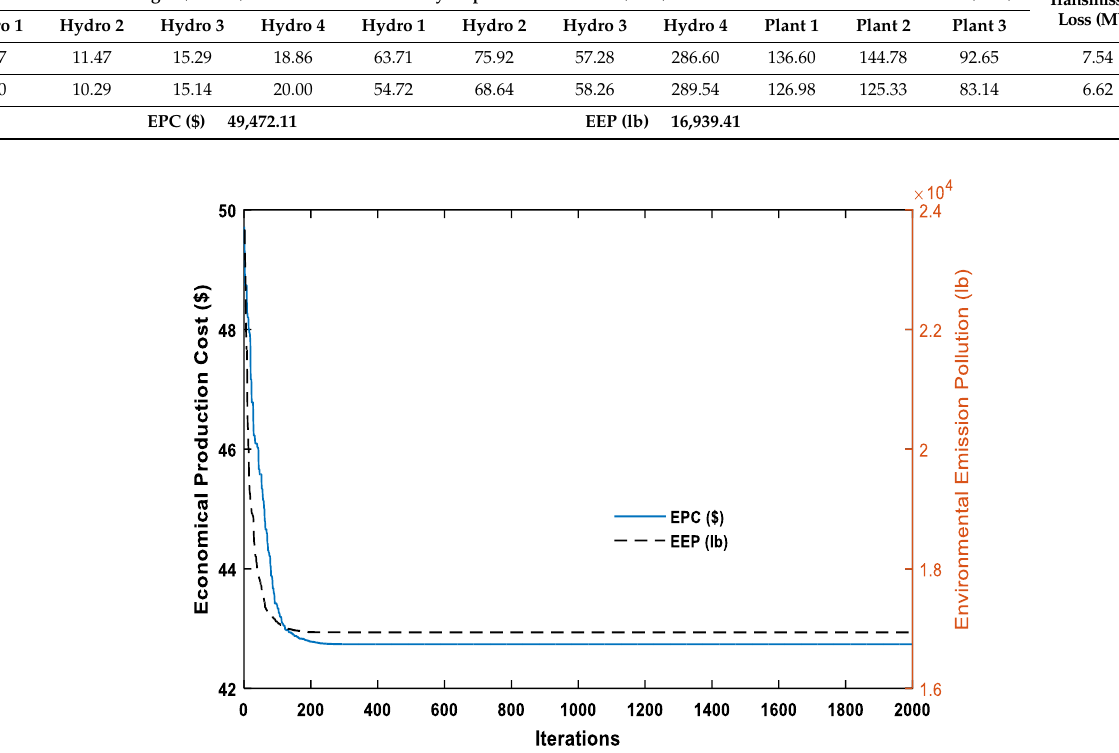
Figure 5. Performance of convergence in EPC and EEP with DOGSA for MSHTS of Test system-II. For MSHTS problem, the detailed objective function values of non-dominated solu- Table 7. EPC minimization schedule results with DOGSA for Test system-II. tions obtained with NSDOGSA approach are listed in Table 9. A fuzzy strategy is used to identify viable result from tradeoff solutions and corresponding optimal hydrothermal schedules are presented in Table 10 and Figure 6, which indicates the satisfaction of all kinds of constraints by using the constraints handling method.